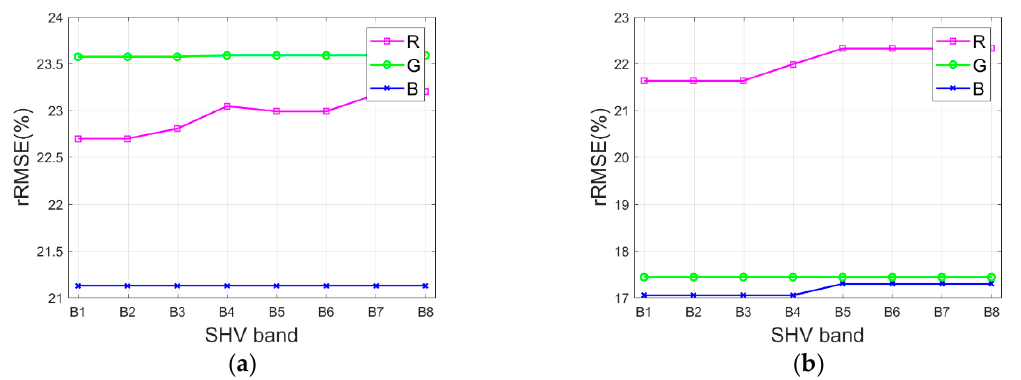
Figure 10. rRMSE of shadow compensation results with various starting haze value (SHV) bands for test images. ( a ) Tripoli-1. ( b ) Tripoli-2.